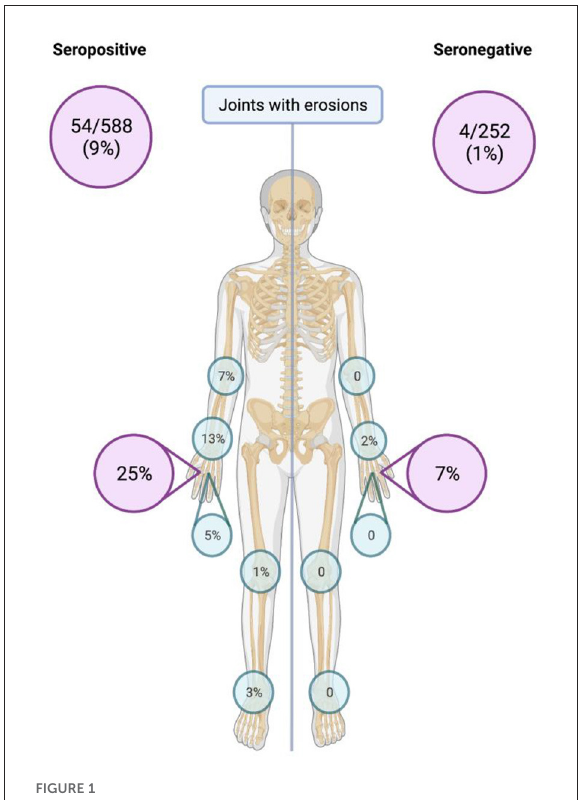
FIGURE1 Total number and percentage of joints with structural joint damage (erosions) detected by ultrasound.